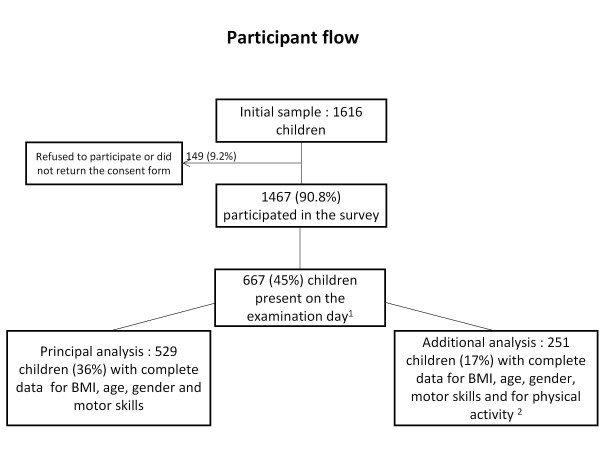
Participant flow. 1The numbers of children are due to the low attendance of children at their child care center (mean attendance 48 ± 2 6%). 2Physical activity measures were only performed in 30 out of 58 randomly selected child care centers.